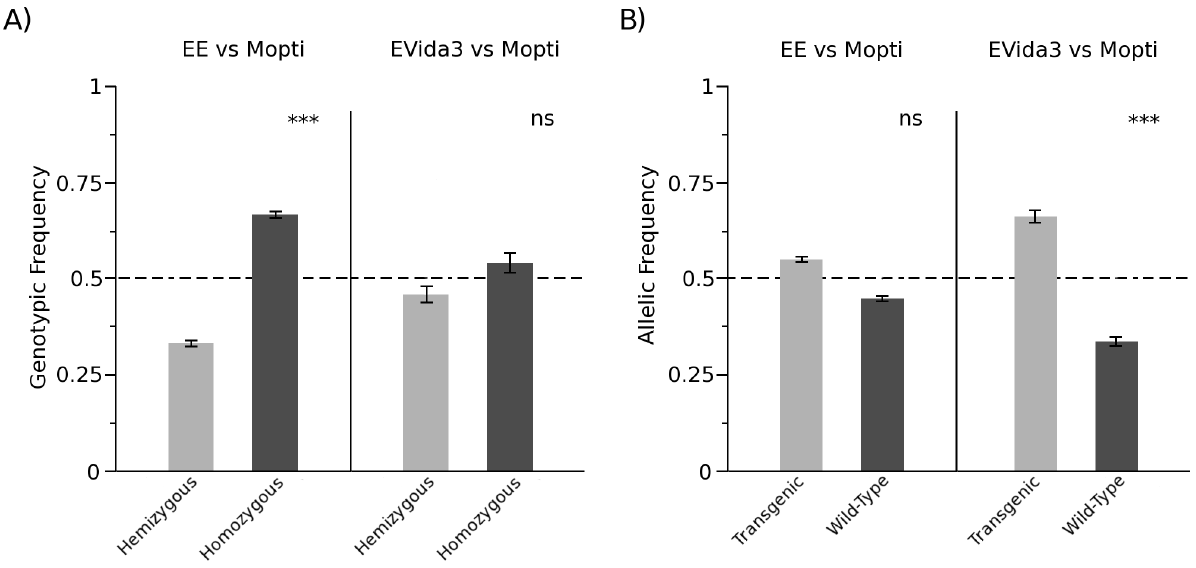
Figure 1. Assortative mating and reproductive success of the transgenic and wild-type lines. In A) the frequency of the hemizygote (TW) and homozygous (WW, TT) genotypes were compared in both the Mopti vs EE and Mopti vs EVida3 comparisons. In B) the frequency of the transgenic (T) and wild-type (W) alleles in both the Mopti vs EE and Mopti vs EVida3 comparisons were compared. Error bars represent 95% confidence intervals. Significance levels of a Chi-square test are indicated - ns, not significant, *: P , 0.05, ** P , 0.01, *** P , 0.001.